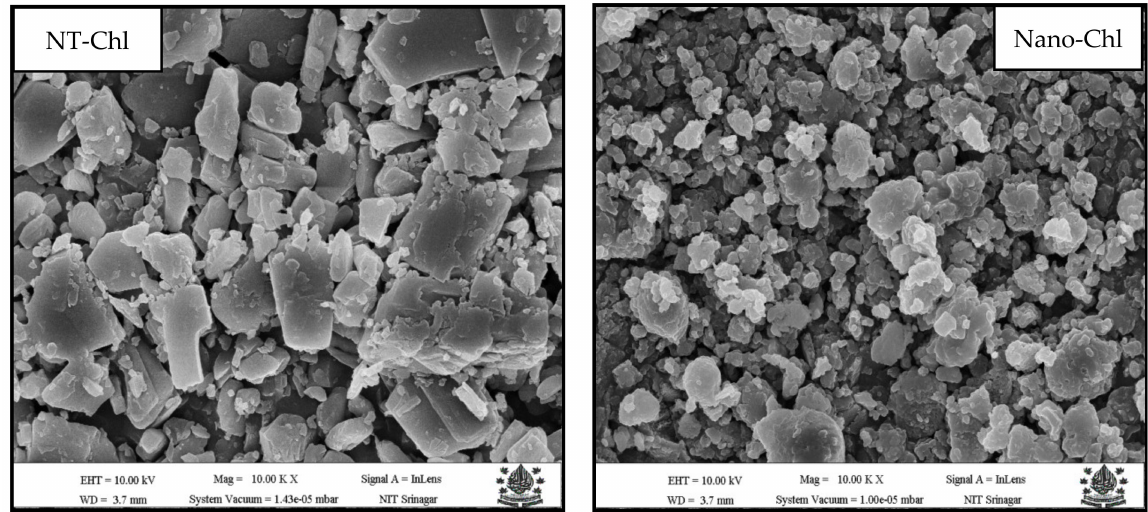
Figure 2. SEM images of NT-Chl and Nano-Chl. Key: For caption, see Table